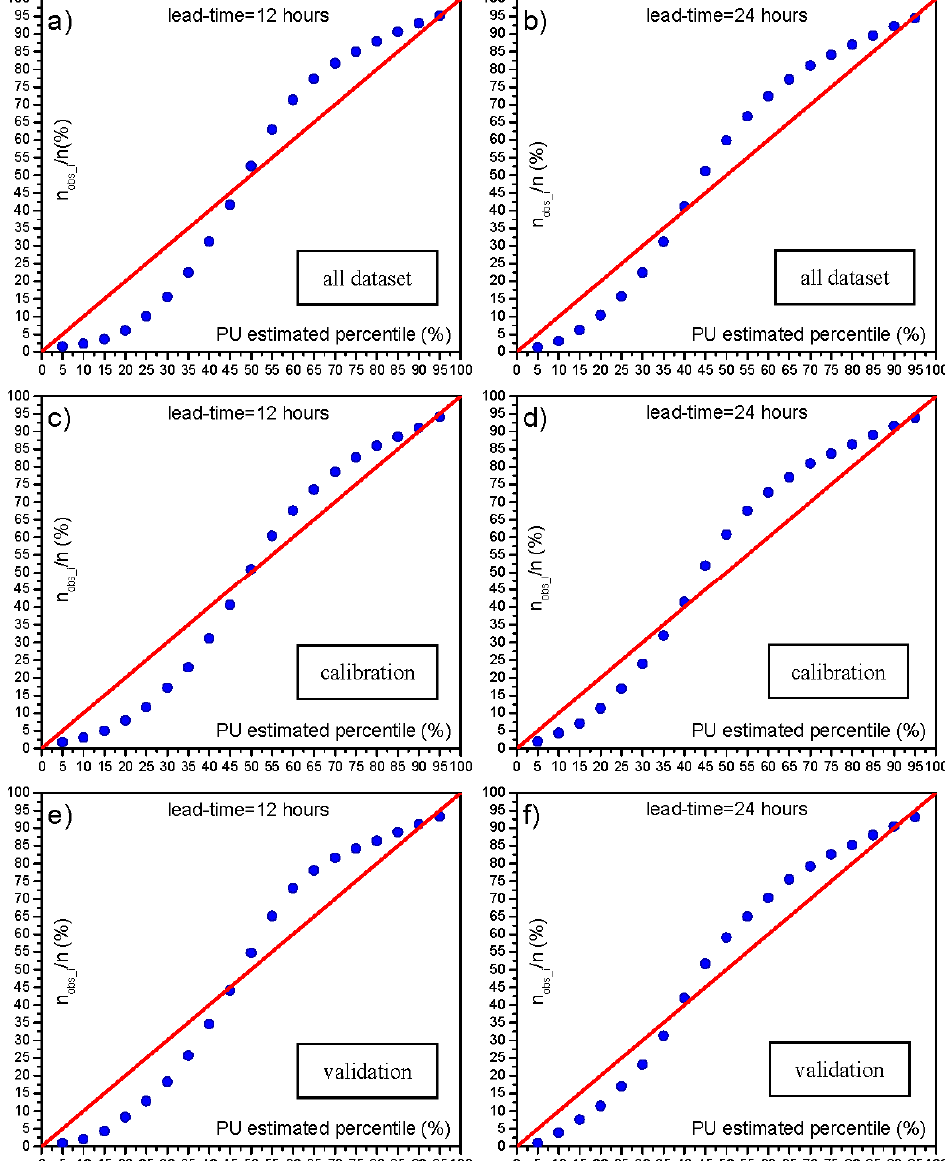
Figure 6. Comparison between the MCP ‐ MT estimated percentiles and the corresponding observed occurrences ( n obs_i = number of occurrences below the i th percentile, n = sample size) for: ( a , b ) all calibration dataset (( a ) reach 1; and ( b ) reach 2); ( c , d ) calibration period 2001–2004 (( c ) reach 1; and ( d ) reach 2); and ( e , f ) validation period 2005, 2007 and 2010 (( e ) reach 1; and ( f ) reach 2). The red line represents the perfect behavior, and the blue shows the MCP ‐ MT response.